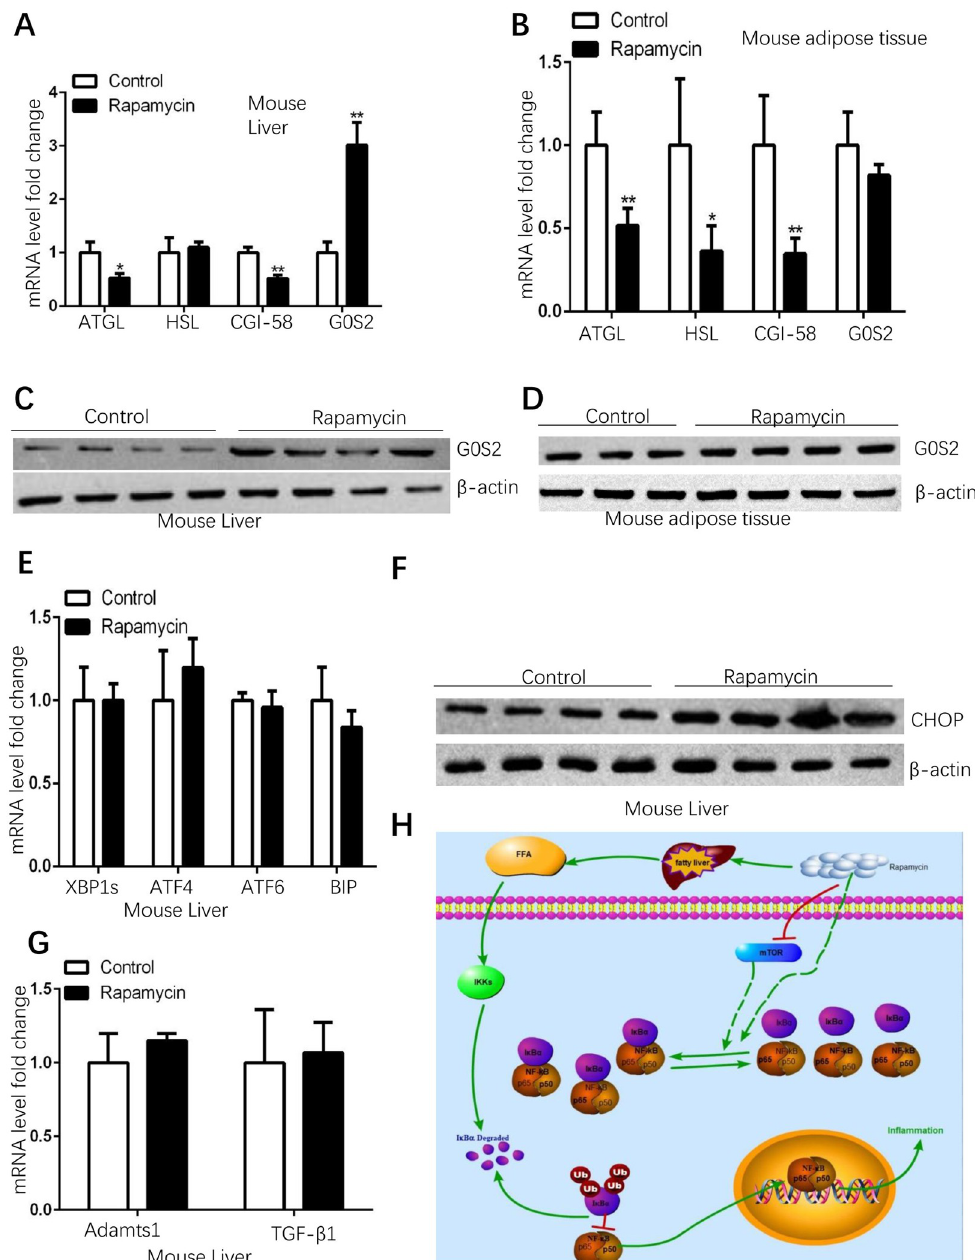
Fig 4. Rapamycin inhibits the lipolysis pathway in rapamycin-induced fatty liver. (Data represent mean ± SEM, �� p < 0.01, � p < 0.05). A. In rapamycin-induced fatty liver, the mRNAs of ATGL were downregulated and G0S2 was upregulated (Control group n = 7, rapamycin-treated group n = 8). B. In the adipose tissues of rapamycin-treated mice, G0S2 mRNA expression was not changed (Control group n = 7, rapamycin-treated group n = 8). C. G0S2 protein level was significantly increased in rapamycin-induced fatty livers (Control group n = 4, rapamycin group n = 4). D. Rapamycin treatment did not change G0S2 protein level in adipose tissue (Control group n = 3, rapamycin group n = 4). E. The mRNAs of ER stress-associated genes were not changed in rapamycin-induced fatty liver (Control group n = 7, rapamycin-treated group n = 8). F. CHOP was upregulated in rapamycin-induced fatty liver (Control group n = 4, rapamycin group n = 4). G. Eighteen weeks of rapamycin treatment did not increase liver fibrosis markers expression (Control group n = 7, rapamycin-treated group n = 8). H. Summary of the mechanisms that rapamycin suppresses inflammation level in rapamycin-induced fatty livers.